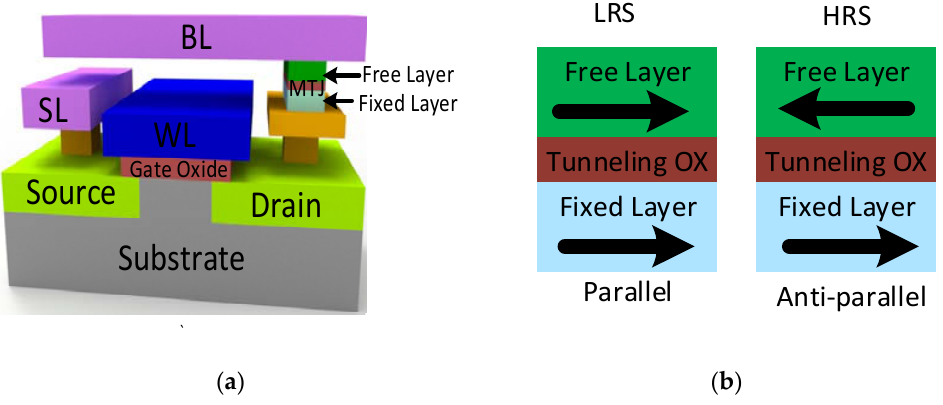
Figure 19. ( a ) A 3D plot of a magnetic tunnel junction (MTJ) with a pass gate transistor; ( b ) free layer to fixed layer orientation of a magnetic tunnel